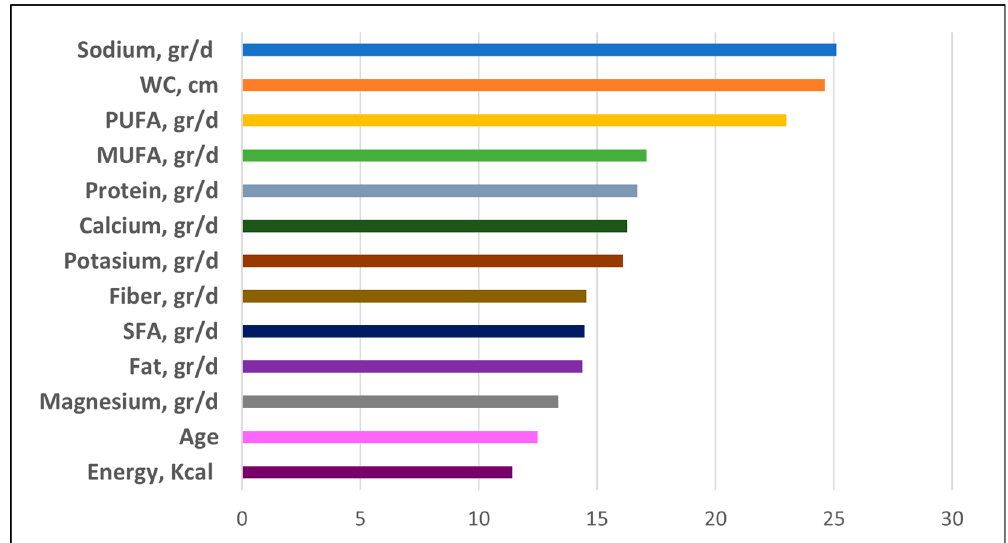
Figure 2. The feature importance of final